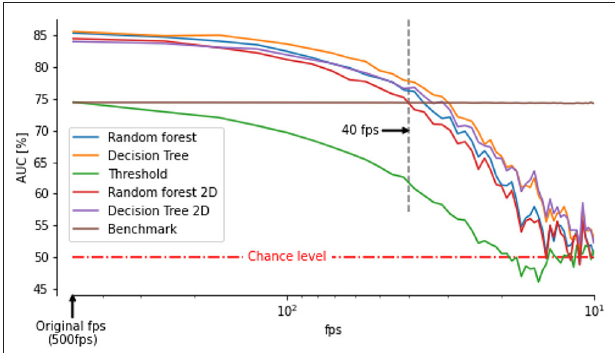
FIGURE 5 | Area under the curve between saccade/intersaccade classifications from classifier or double thresholds on thorax angular velocity and head saccade/intersaccade classification as a function of frame rate. The benchmark is the classification from ω z of the thorax based on the optimally chosen double threshold at 500 fps. The classifier outperform the benchmark for frame rates above 40 fps even when angular velocity of the thorax is determined by assuming zero pitch and roll orientation (classifier followed by